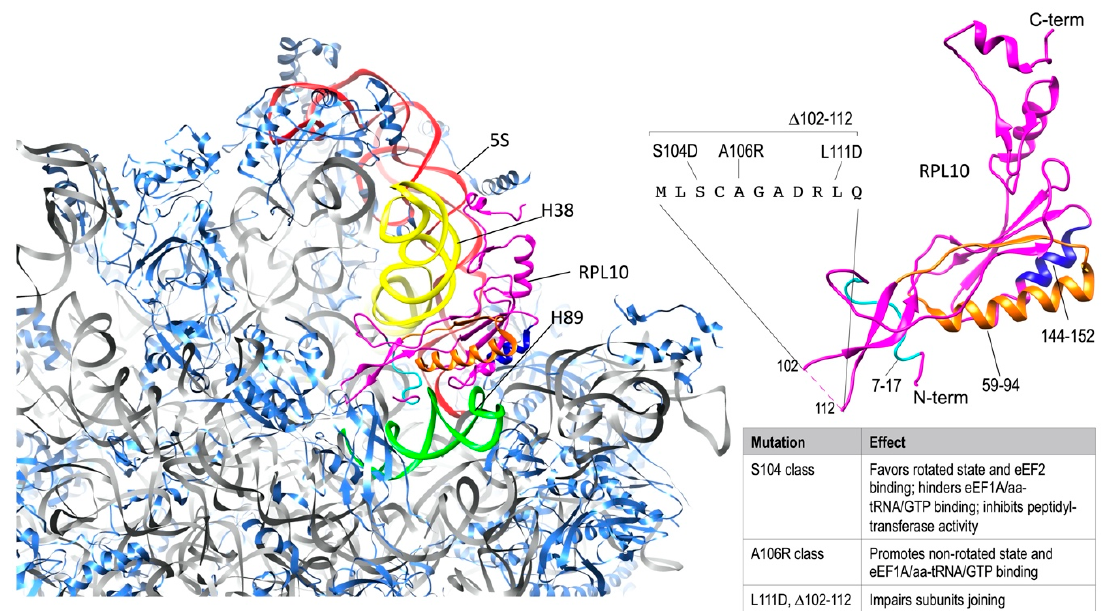
Figure 3. RPL10 ribosomal functions. On the left, Rpl10 in S. cervisiae 60S subunit (40S-exposed side); 25S rRNA is represented in grey (except for the colored portions, explained below) and RPLs other than Rpl10 are represented in cornflower blue. The regions of Rpl10 (magenta) that are relevant for interactions with rRNAs have been highlighted with different colors as follows: the portion including aminoacids 7-17 (light blue) is involved in contacting H89 in 25S rRNA (green); the portion including aminoacids 59-94 (orange) is placed between H38 in 25S rRNA (yellow) and H39 in 18S rRNA (not shown); the portion including aminoacids 144-152 (blue) is in close proximity of H89 (green); the C-terminal region is in contact with 5S rRNA (red). On the right side of the figure, Rpl10 structure is magnified and consistently colored. The unresolved sequence of the P-loop, with the different classes of mutations, as reported in the main text, has been added and the effects of the mutations in this site have been summarized in the side table. The figure was generated using UCSF Chimera [46].